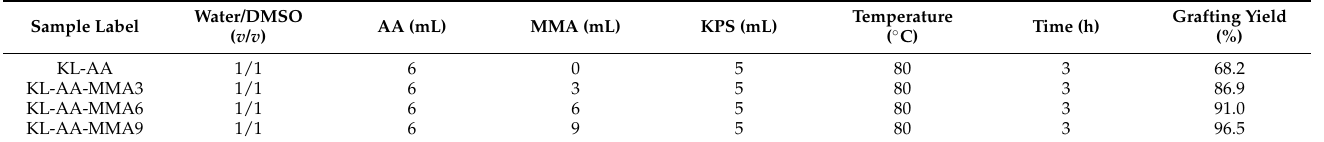
Figure 1. Schematic illustration for the synthetic process of KL-AA-MMA nanoparticles. Table 1. Reaction conditions and grafting yields of KL-AA and KL-AA-MMA